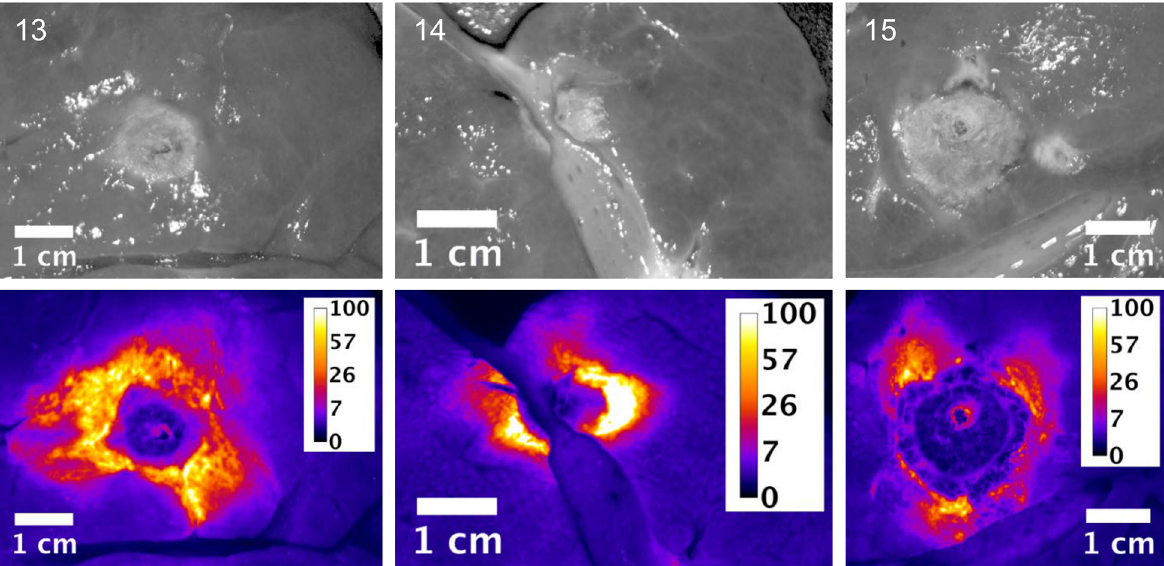
Fig 7. Plain and fluorescent images of ablation zone in pigs in Study C, group 1. Each pig received a single 12 minutes ablation and 3 minute cool down (total time = 15 minutes) with the Angiodynamics device. Scale is μ g/g doxorubicin.